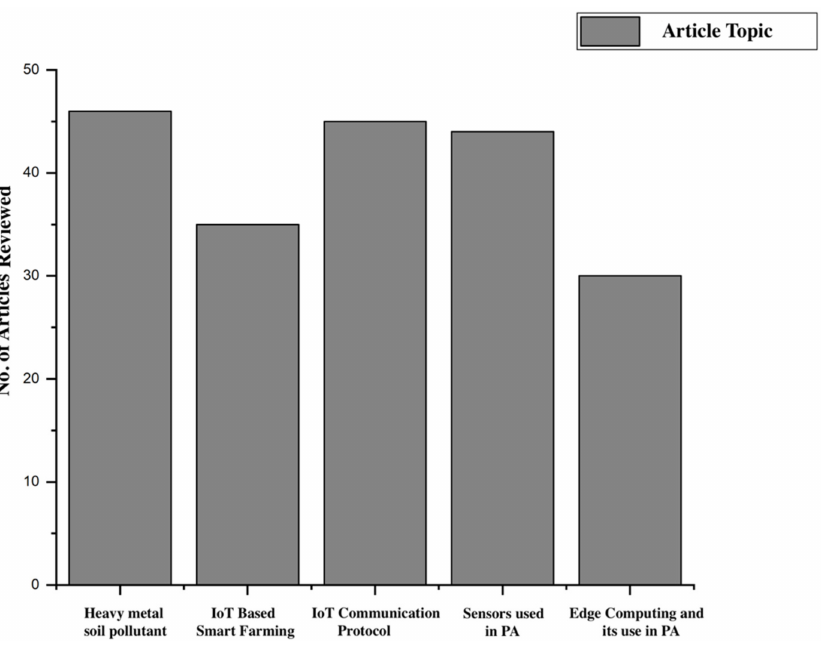
Figure 1. Distribution of reviewed